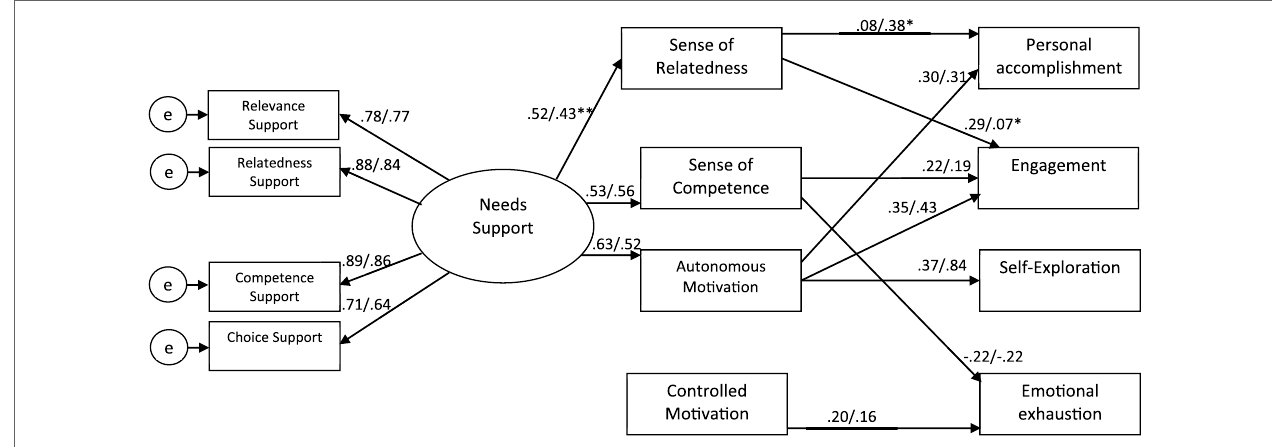
FigUre 2 | Class-specific path analysis results. Numbers represent Arab/Jewish populations’ coefficients. * indicates significant differences between coefficients. All paths presented are significant at p < 0.05 for at least one population; non-significant paths were removed and constrained to 0.